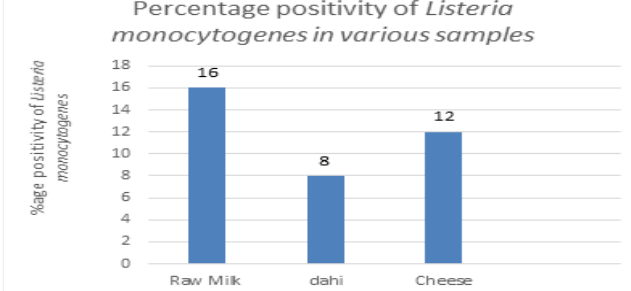
Fig. 2 Percentage positivity of Listeria monocytogenes in various samples 3. Isolation of Listeria Species 3.1. Media pouring Media was poured in different petri plates.